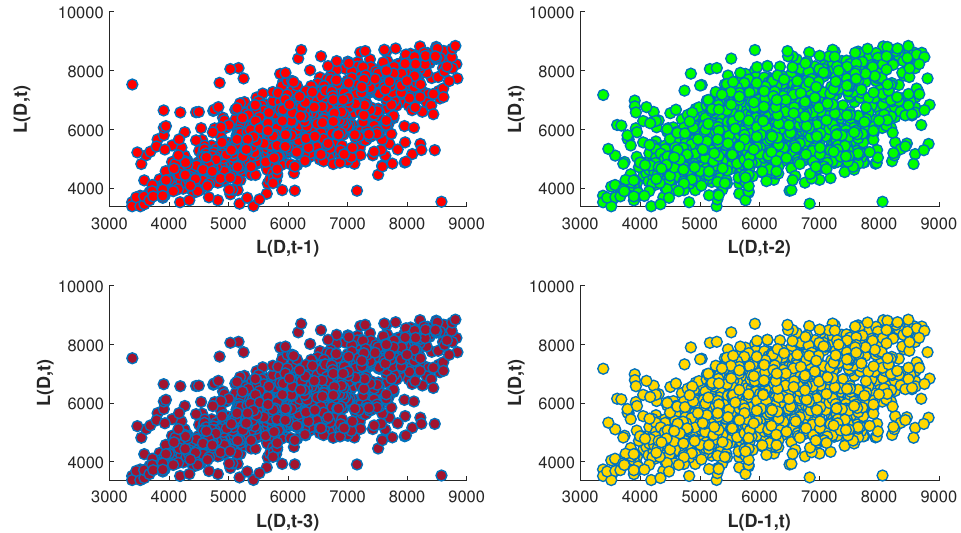
Figure 8. Impact of each input feature on output